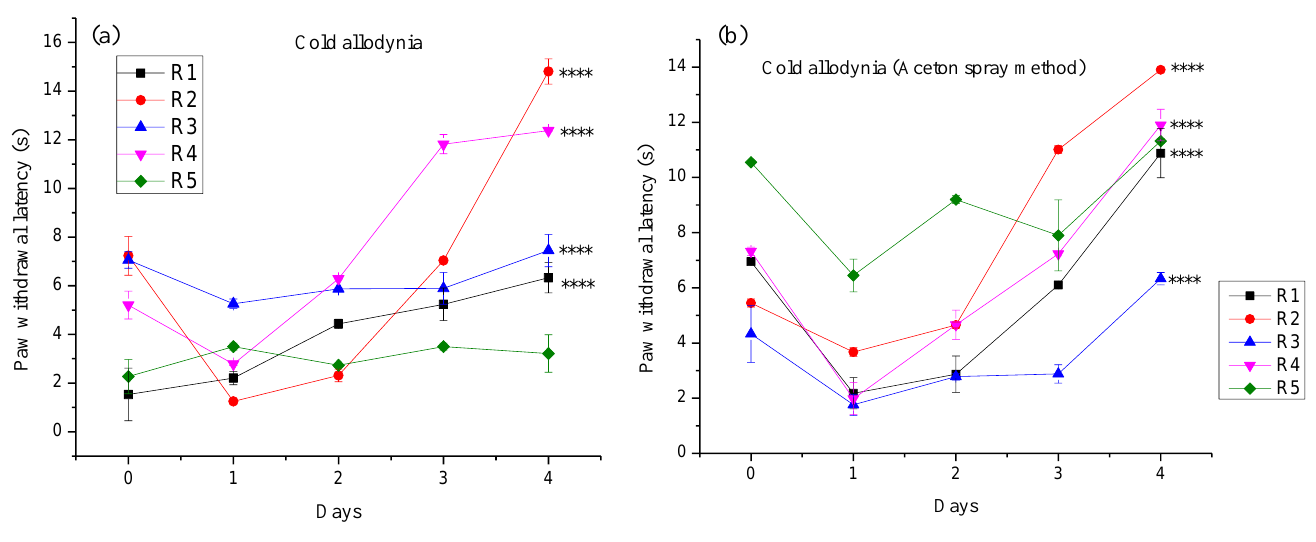
Figure 9. Cold allodynia ( a ) and acetone spray method ( b ). Where, **** represents very much sig- nificant.